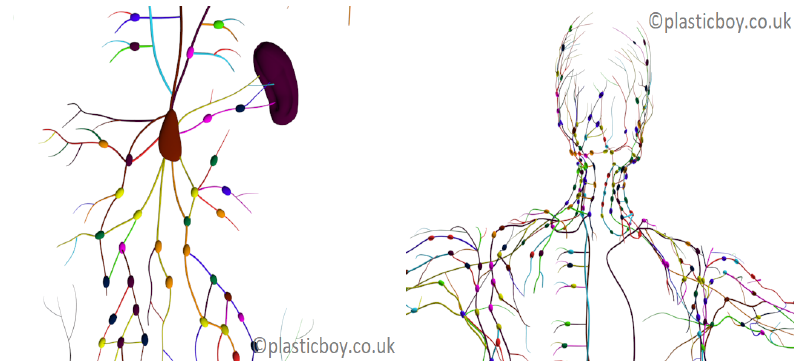
Figure 4. Some mismatches of the lymphatics system model of PlasticBoy [20]. ( Left ) Disconnected lymph node; ( Right ) disconnected vessels.